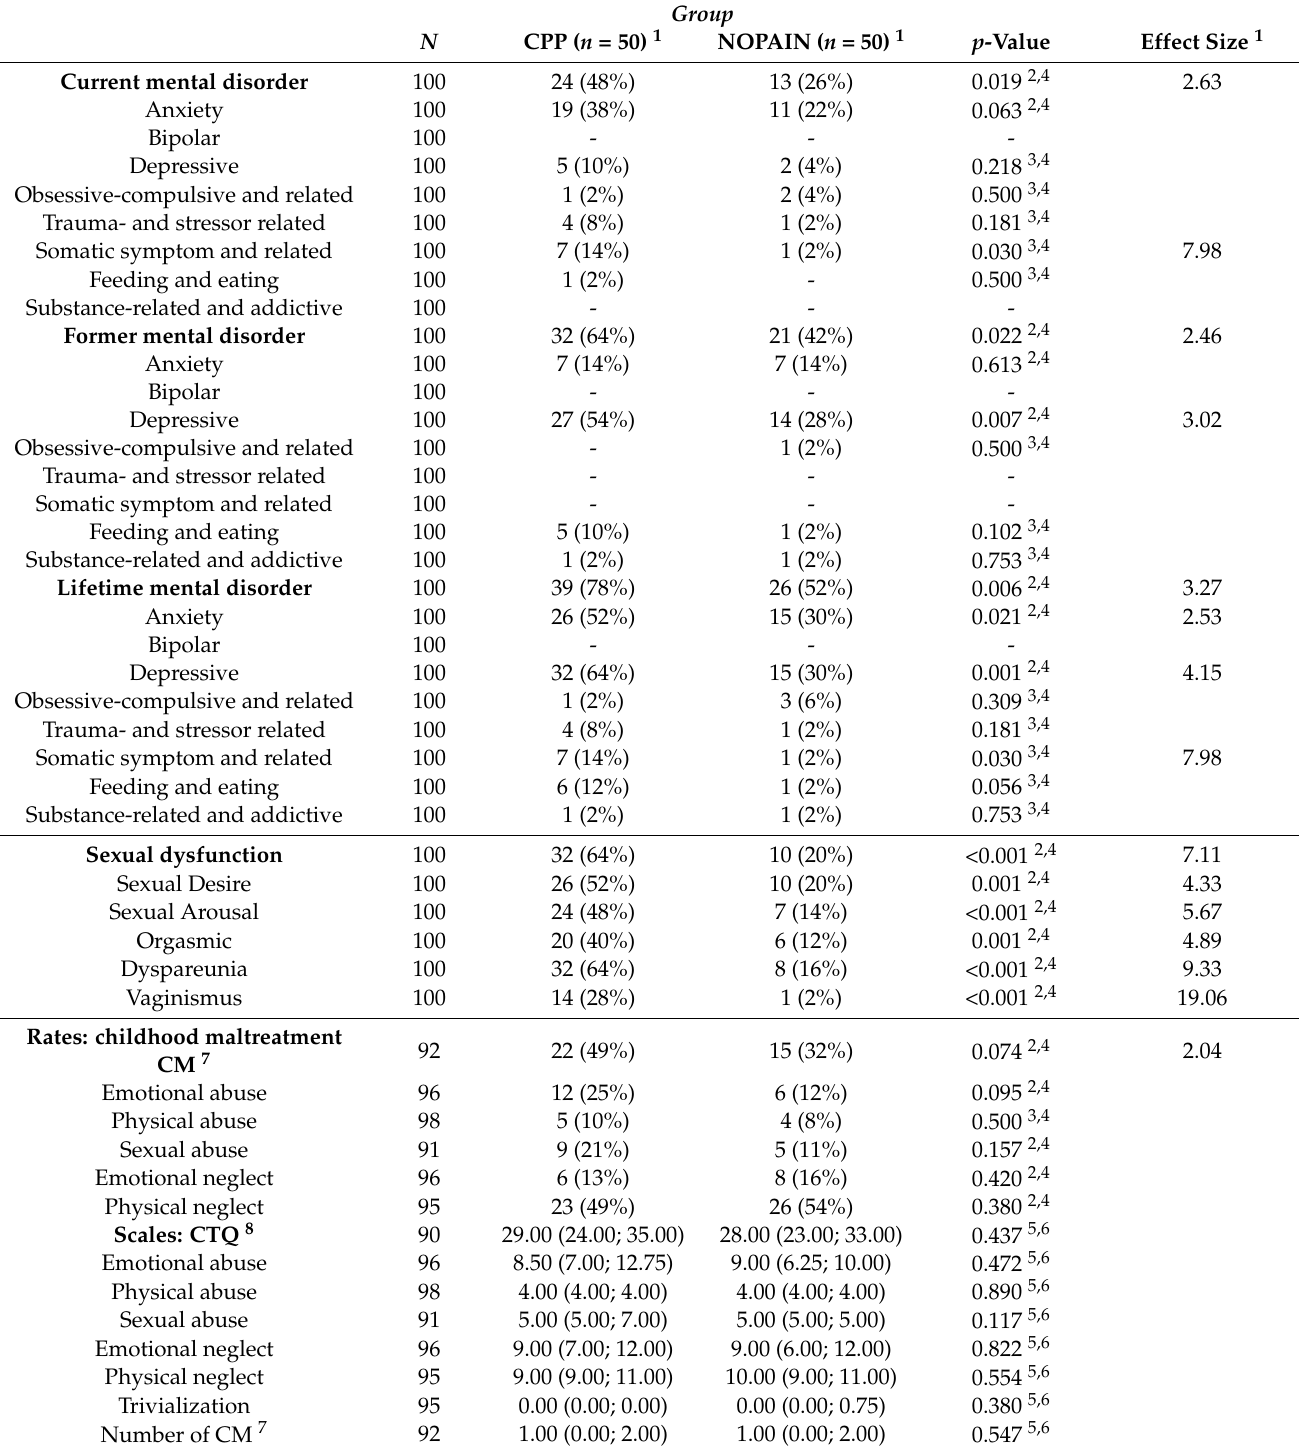
Table 2. Testing of hypotheses: comparisons of the rates of mental disorders, sexual dysfunctions and childhood maltreatment in the groups CPP and